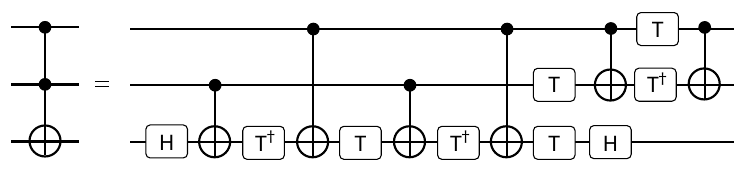
Figure 7: Toffoli gate implemented with single- and two-qubit gates.